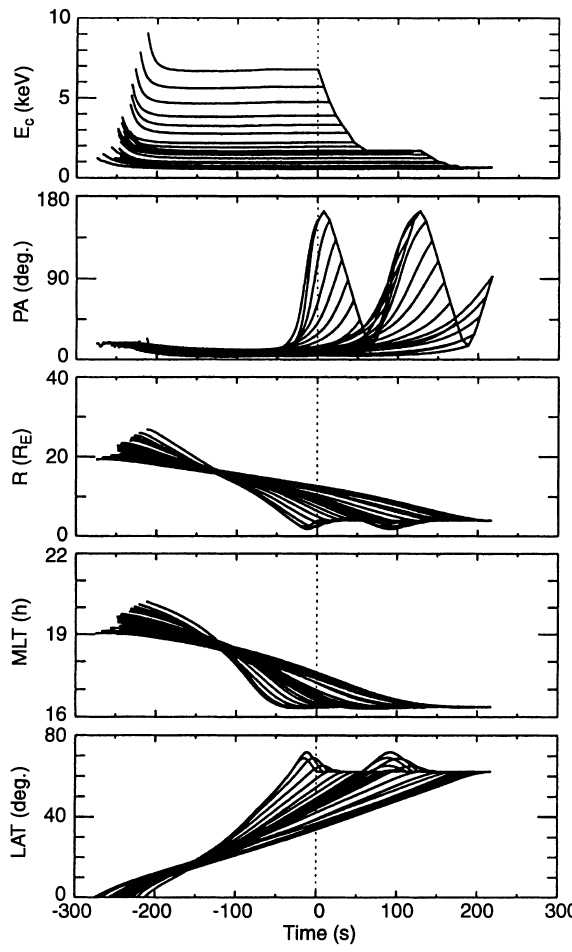
Fig. 9. Result of trajectories computed backward in time for the main ion energy/pitch angle structure displayed in Fig. 8. A 3D model of magnetic and electric fields is used (see text). At the top, the right black curve is the energy of the maximum ion fluxes between 02:47 ( T = 0) and 02:50:30 UT. Energy variations when backward computations are performed are indicated. Next panel: ion pitch- angle and its backward variations for selected energies. The three bottom panels give the variation of the radial distance, magnetic local time, and magnetic latitude of the particles forming the energy/pitch angle structure measured after T = 0. Note the focal point at about T = ) 130